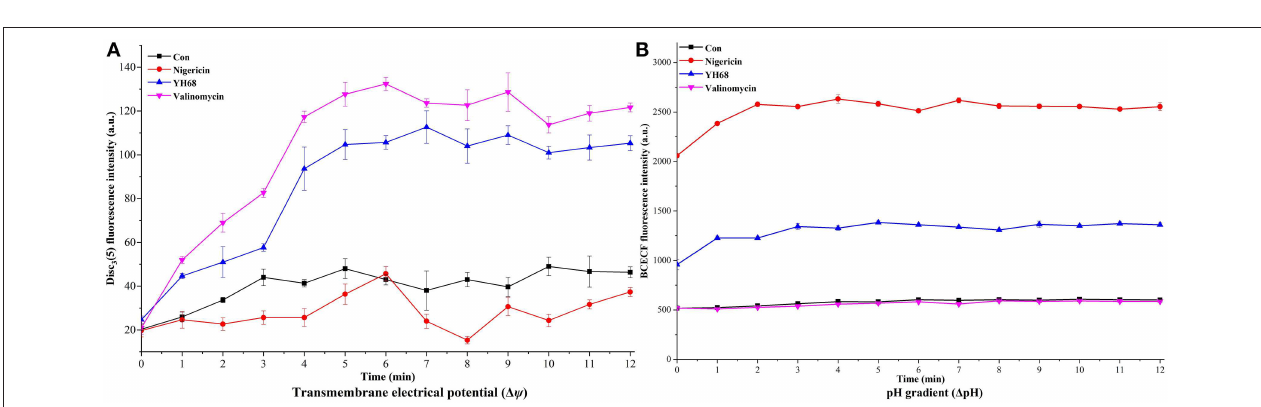
FIGURE 8 | Confocal laser scanning micrographs of C. difficile ATCC 9689 treated with YH68-CFCS for 1, 2, 3h.